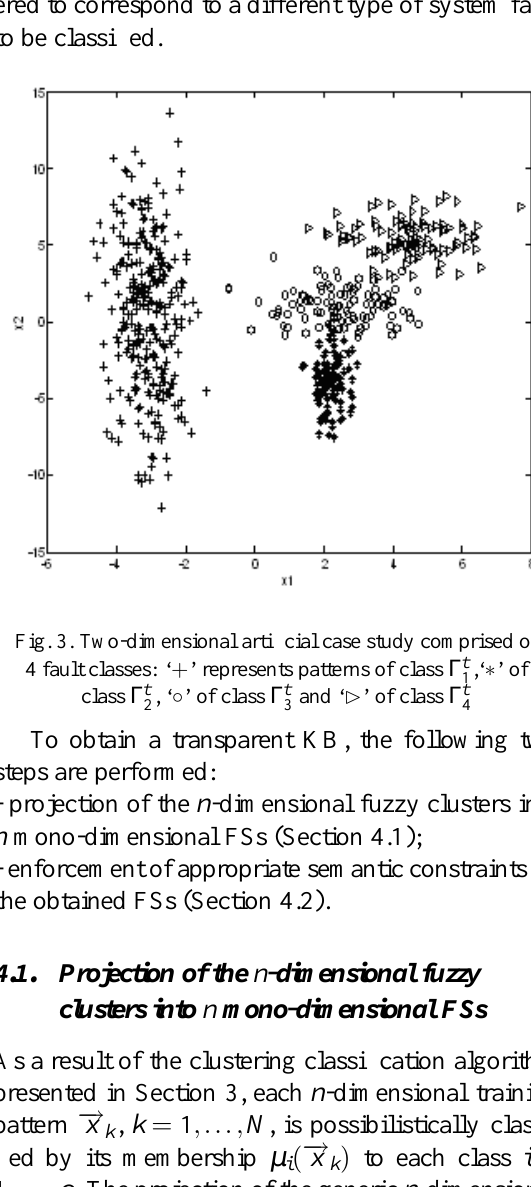
Fig. 4. Projections of the cluster of Fig. 3, corresponding to class G t onto the UODs of the 2 antecedents x 1 and x 2 2 (abscissa: antecedent values; ordinate: membership value of the generic k -th pattern to the cluster projection, k = 1 ,...,